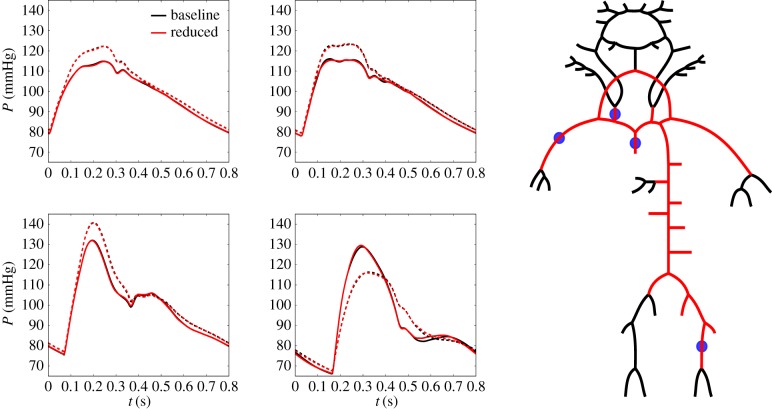
Optimal reduced network for ascending aorta (top left), right common carotid artery (top middle), right brachial artery (bottom left) and left femoral artery (middle bottom). The network is the same as shown in figure 13; however, a pathological state of aortic coarctation (dashed lines) as described in §2.6 is also shown.